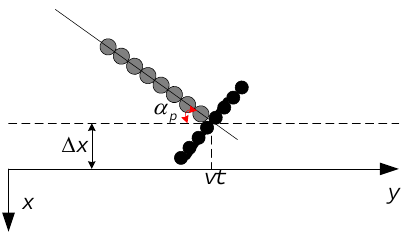
Figure 4. Geometry of sway and yaw in the x - y plane.